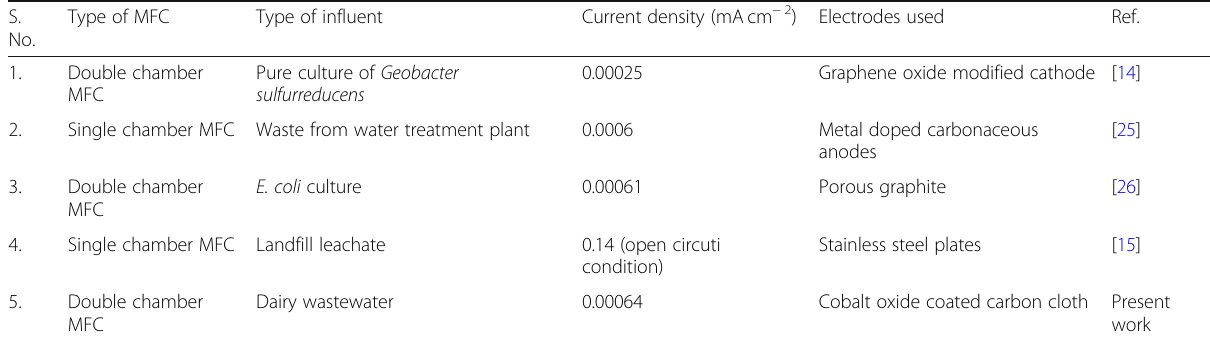
Table 1 Comparison of output for different electrode setup S.